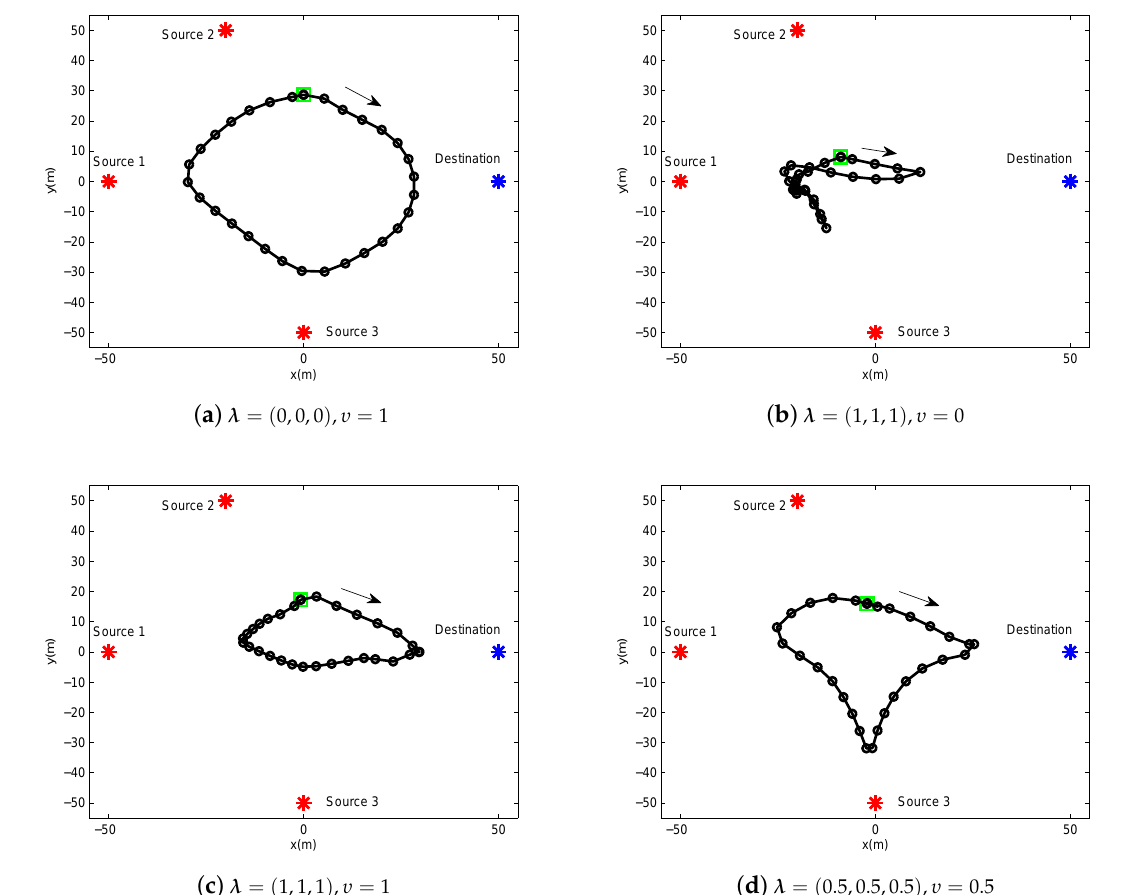
Figure 4. The trajectory of delay-sensitive case for period T = 60 s under different factor λ , υ .